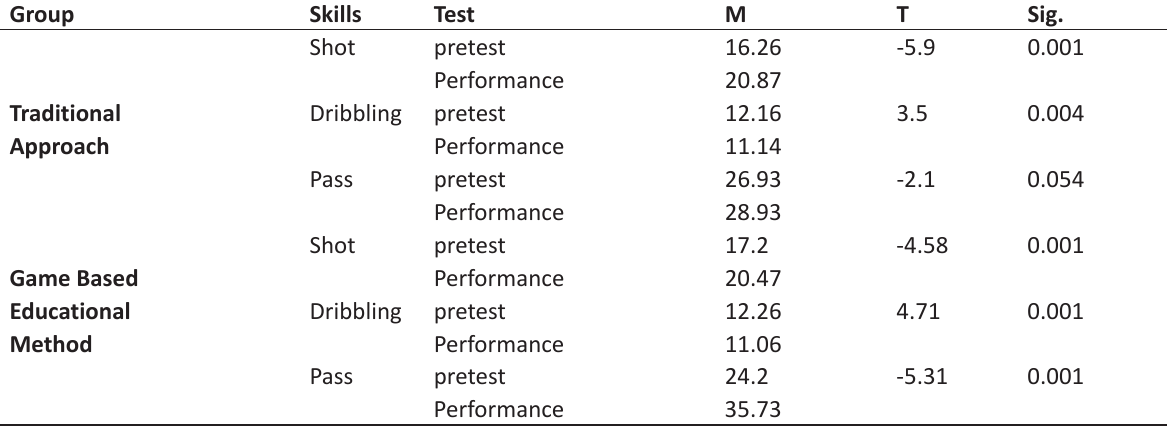
Table 1. The Effect of Two Methods of Teaching on Performance in Basketball Skills